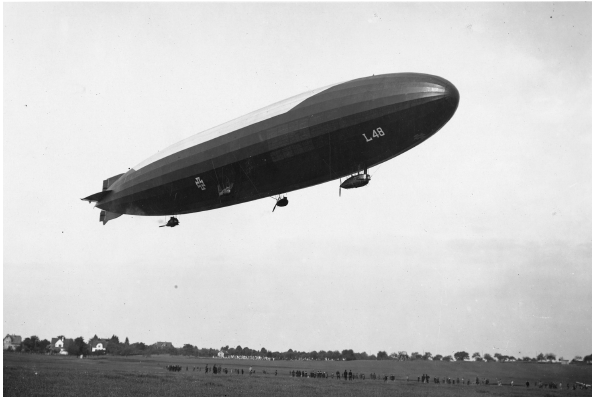
Figure 3. Airship LZ 95 ( L48 ), the ship Almstedt flew with during the Verdun reconnaissance activities. © Archiv der Luftschiffbau Zeppelin GmbH, with